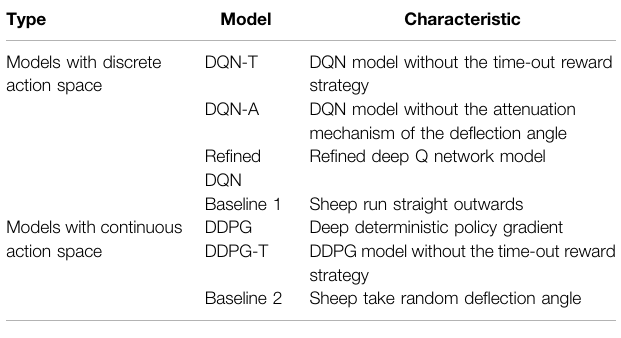
TABLE 1 | Models adopted in our experiments.